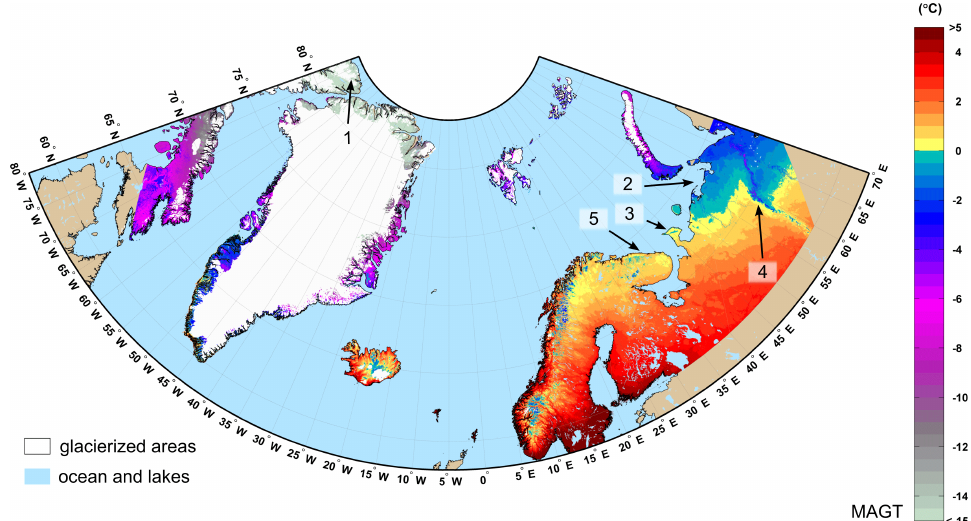
Figure 4. Average MAGT of all model realizations for the North Atlantic study region. 1: Ellesmere Island; 2: Pechora Sea; 3: Kanin Peninsula; 4: Ural Mountains; 5: Kola Peninsula. Glacierized areas from Natural Earth (www.naturalearthdata.com).